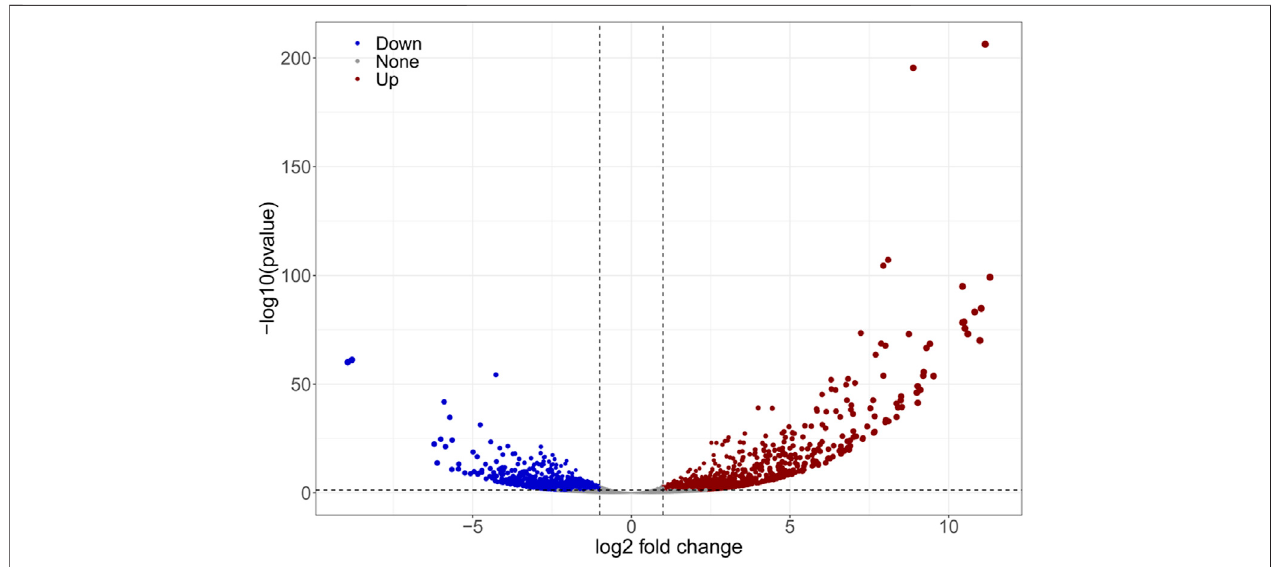
FIGURE6| Volcanoplotshowingthecharacteristicsofdifferentiallyexpressedgene.Thedotsrepresentgenes,amongwhichtheblueandreddotsaregenesthat satis fi ed FC < 0.5, FC > 2 and p < 0.05 and thus differed in expression between the two samples.